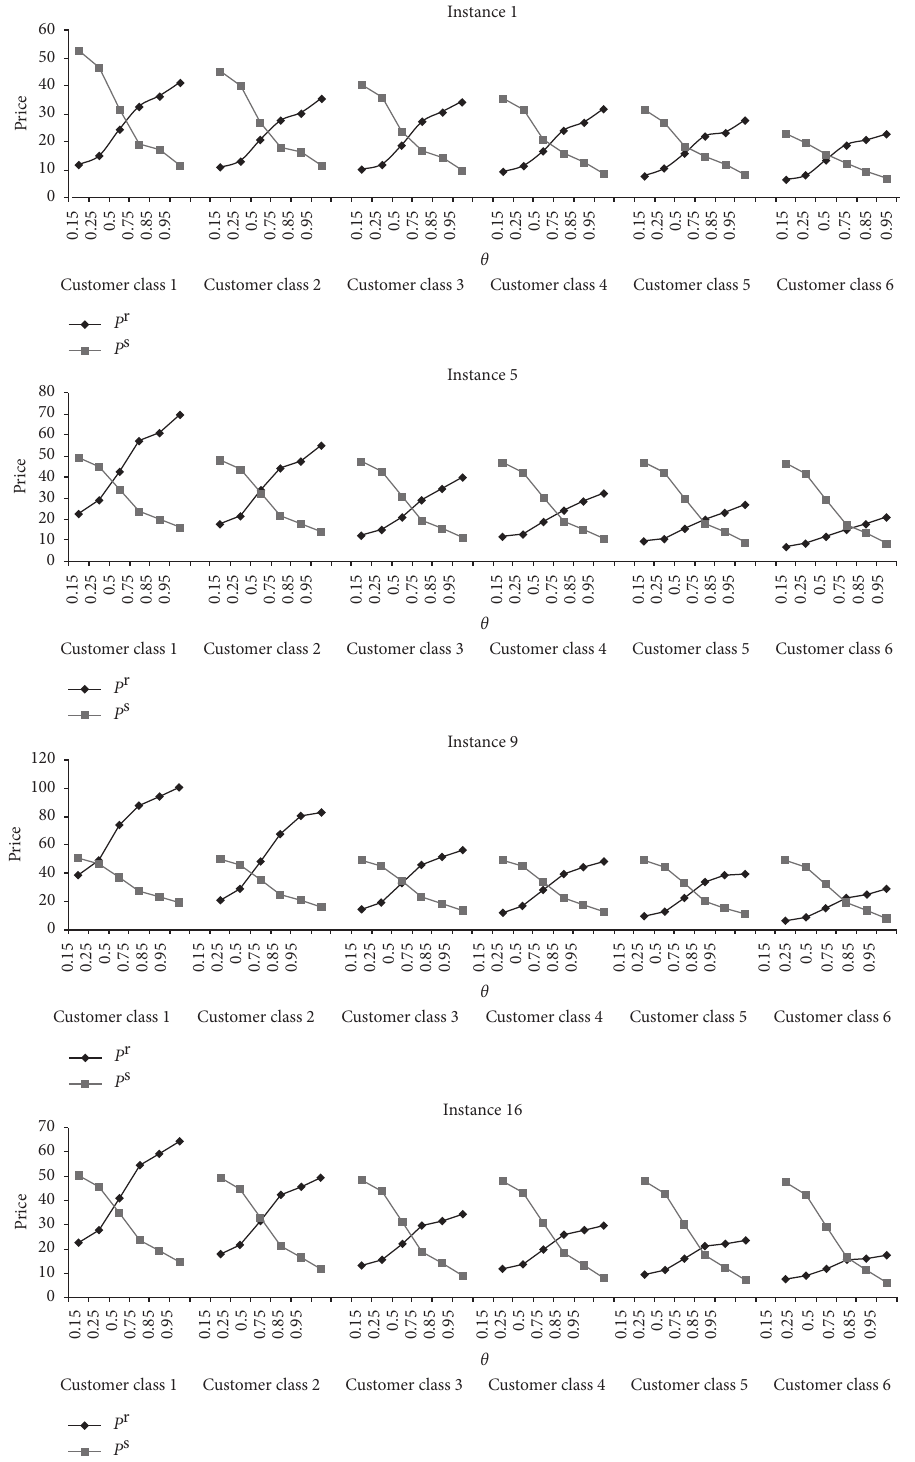
Figure 8: Comparison of the retail price and direct sale price in centralized dual-channel supply chain for different